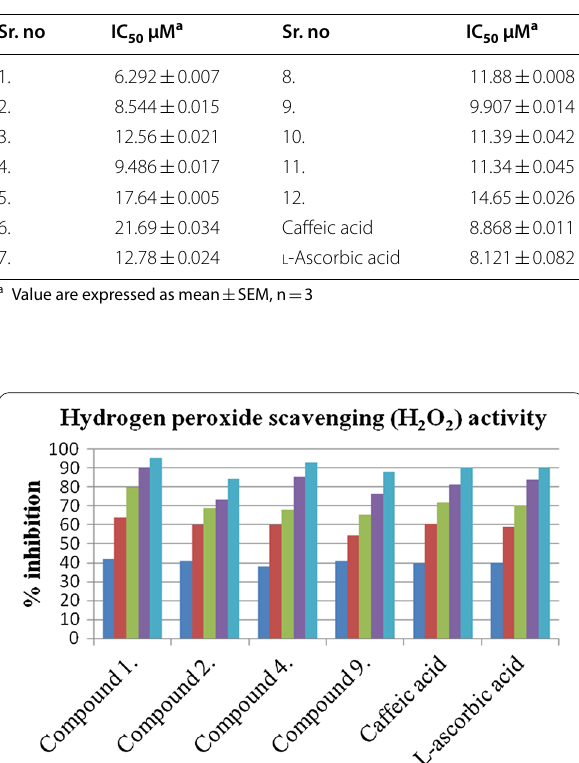
Table 5 H O radical scavenging activity of caffeic acid 2 2 derivatives